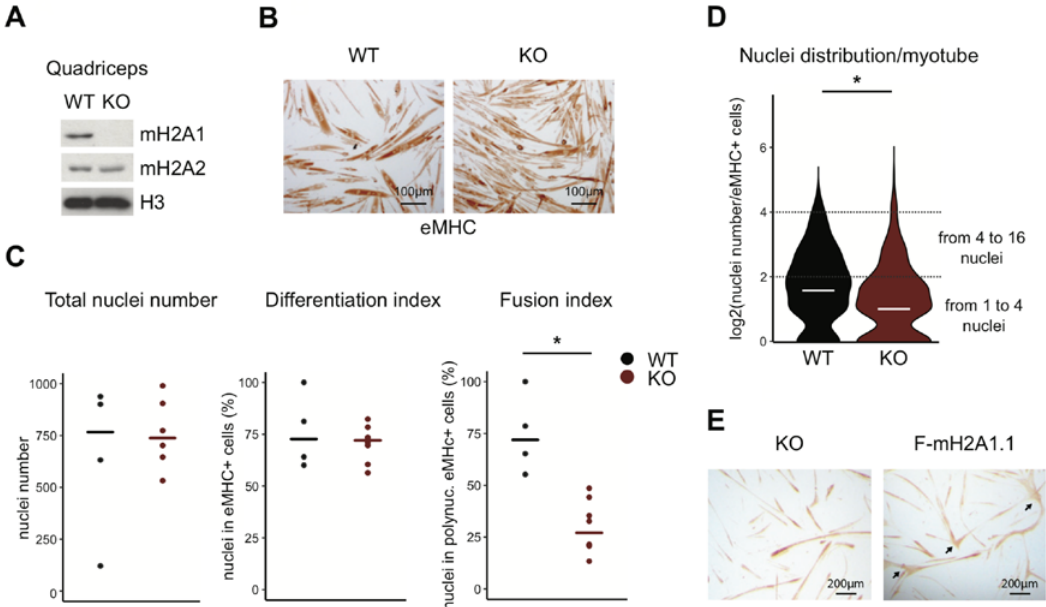
Figure 1. Myoblasts lacking macroH2A1 fail to form proper myotubes. ( A ) Immunoblot analysis of macroH2A1 (mH2A1), mH2A2 and Histone H3 of quadriceps from wild-type (WT) and knockout (KO) mice. ( B ) Immunostaining of di ff erentiated primary mH2A1 WT and KO myotubes with anti-embryonic myosin heavy chain (eMHC). ( C ) Total nuclei, percent of di ff erentiated eMHC positive cells and percent of di ff erentiated eMHC positive cells with at least two nuclei after four days of di ff erentiation. Data points are from sets of four to six photos obtained from three independent biological replicates, evaluating 100 and 200 myotubes and the same surface area per replicate. Lines indicate the median of replicates, * p < 0.05, Student’s t -test. ( D ) Violin graph of the nuclei distribution per primary mH2A1 WT and KO myoblasts. The data shown are the log2 of the median of 100–200 myotubes from three biological replicates, * p < 0.05, Wilcoxon test. ( E ) Bright field pictures of anti-eMHC immunostainings of primary macroH2A1 KO myoblasts transduced with Flag-mH2A1.1 or control vector after two days of di ff erentiation. Arrows indicate large myotubes. 3.2. MacroH2A1 Isoforms Have an Opposing Effect on Cell Fusion—MacroH2A1.1 Promotes and